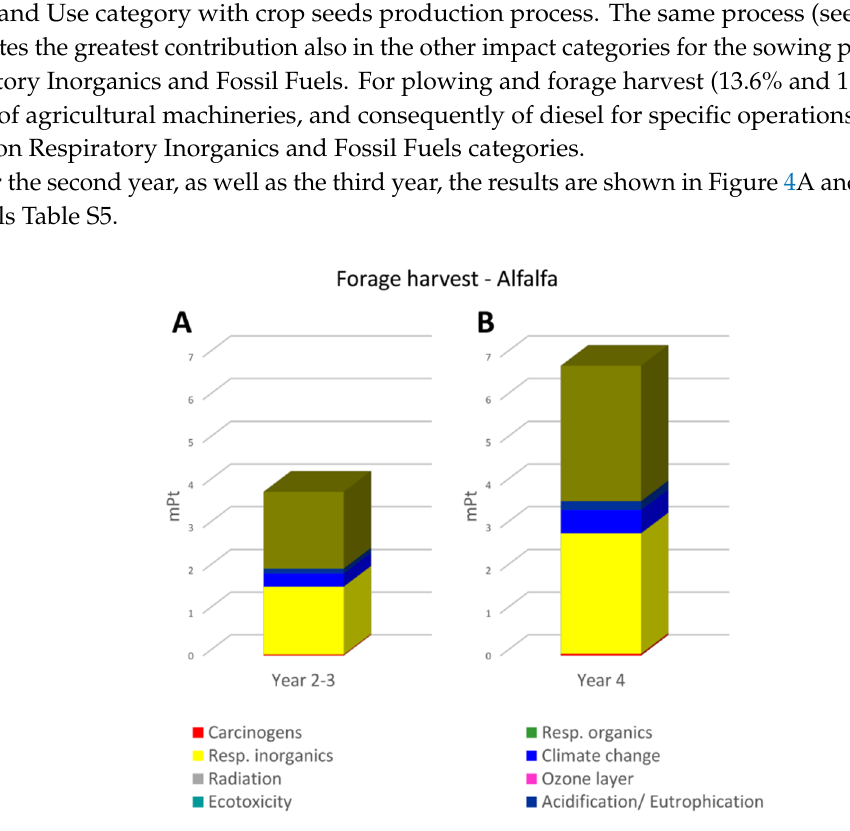
Figure 4. Alfalfa’s impacts in the second-third year ( A ) and in the fourth year ( B ) in milli-Points (mPt).